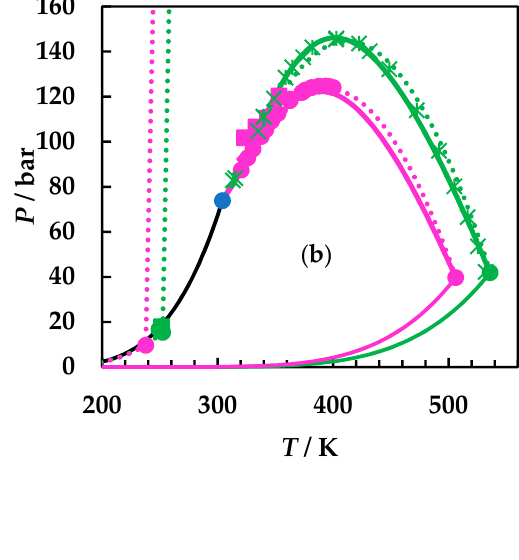
Table 9. The critical compressibility factor ( Z c ), and GEOS parameters ( Ω a , Ω b , Ω c , Ω d , B ).